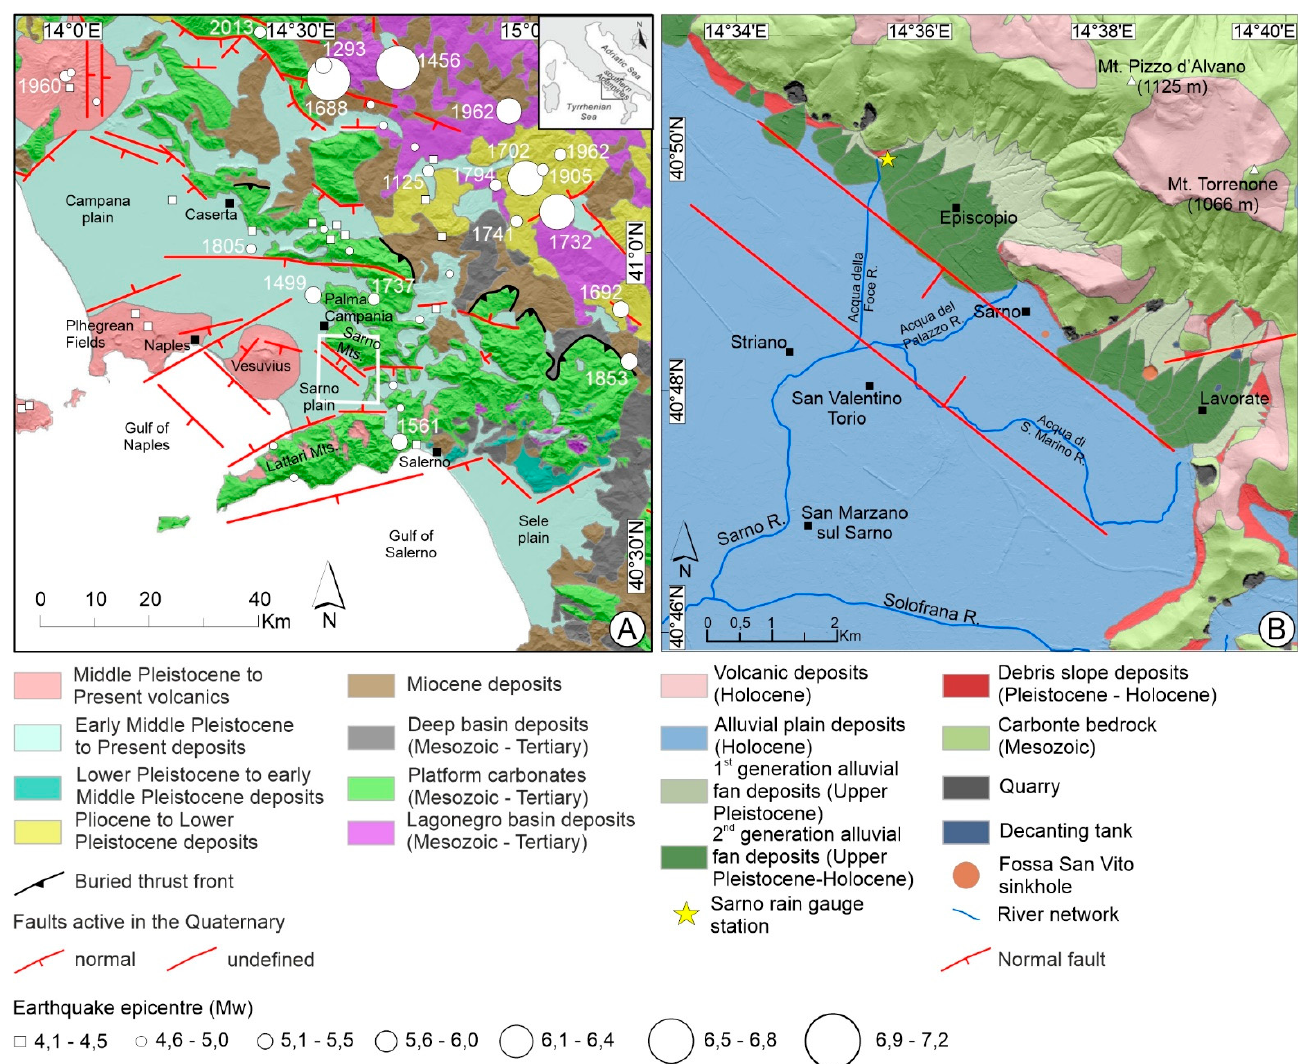
Figure 1. ( A ) geological map of the sector of the Southern Apennines including the Sarno plain (modified from [20,34]). White box indicates location of the study area, shown in inset map B. Active faults are derived from the ITHACA database [35] and from Cinque et al. [36]. Earthquake epicentres and magnitude are derived from the Italian Earthquake Catalogue CPTI15 [37]. ( B ) geological map of the inner sector of Sarno plain (modified from [20]).